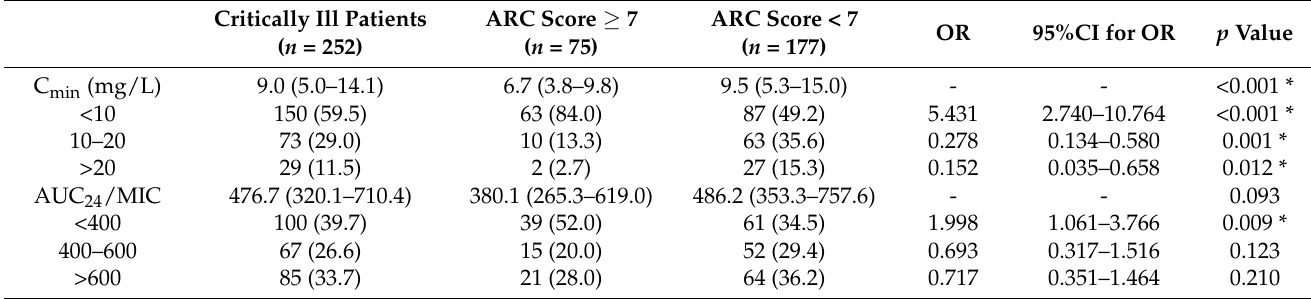
Table 5. PK/PD analysis under the evaluation of the ARC scoring